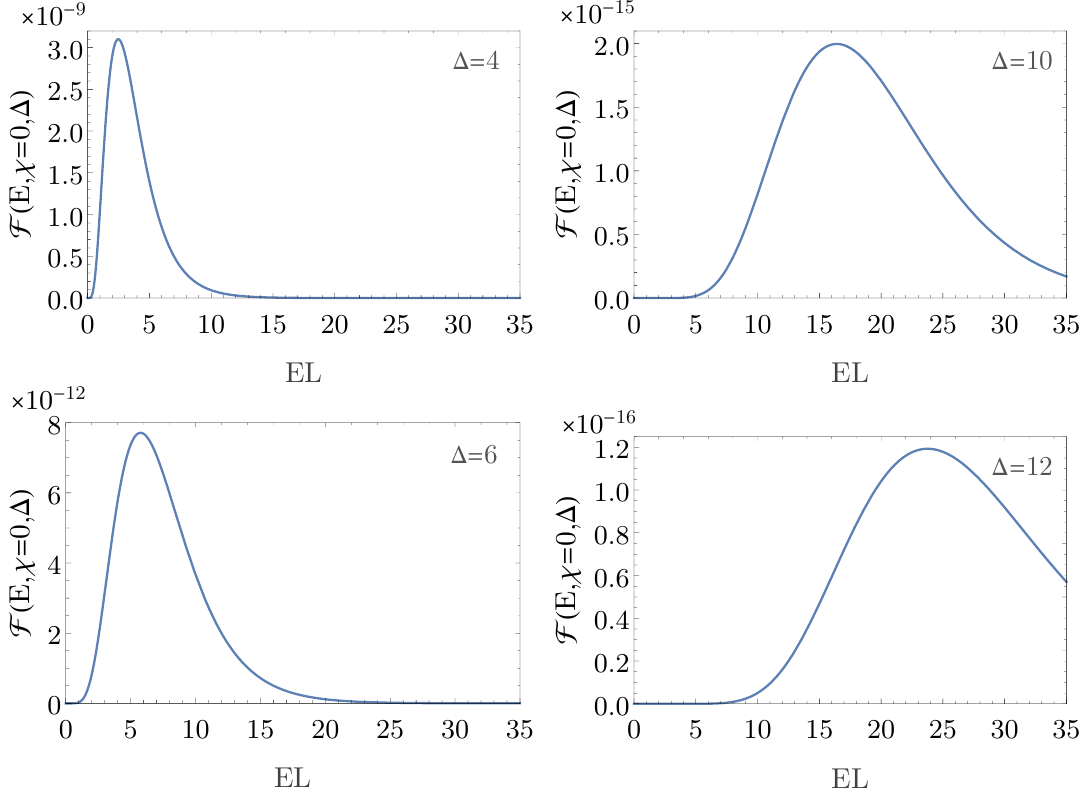
Figure 1 . Average of the square of matrix elements F ( E; (cid:31) = 0 ; (cid:1)) of a scalar primary of dimension (cid:1) as a function of the energy E of the states (for states with the same energy), obtained from eq. (3.5) with (cid:31) = 0 and c =